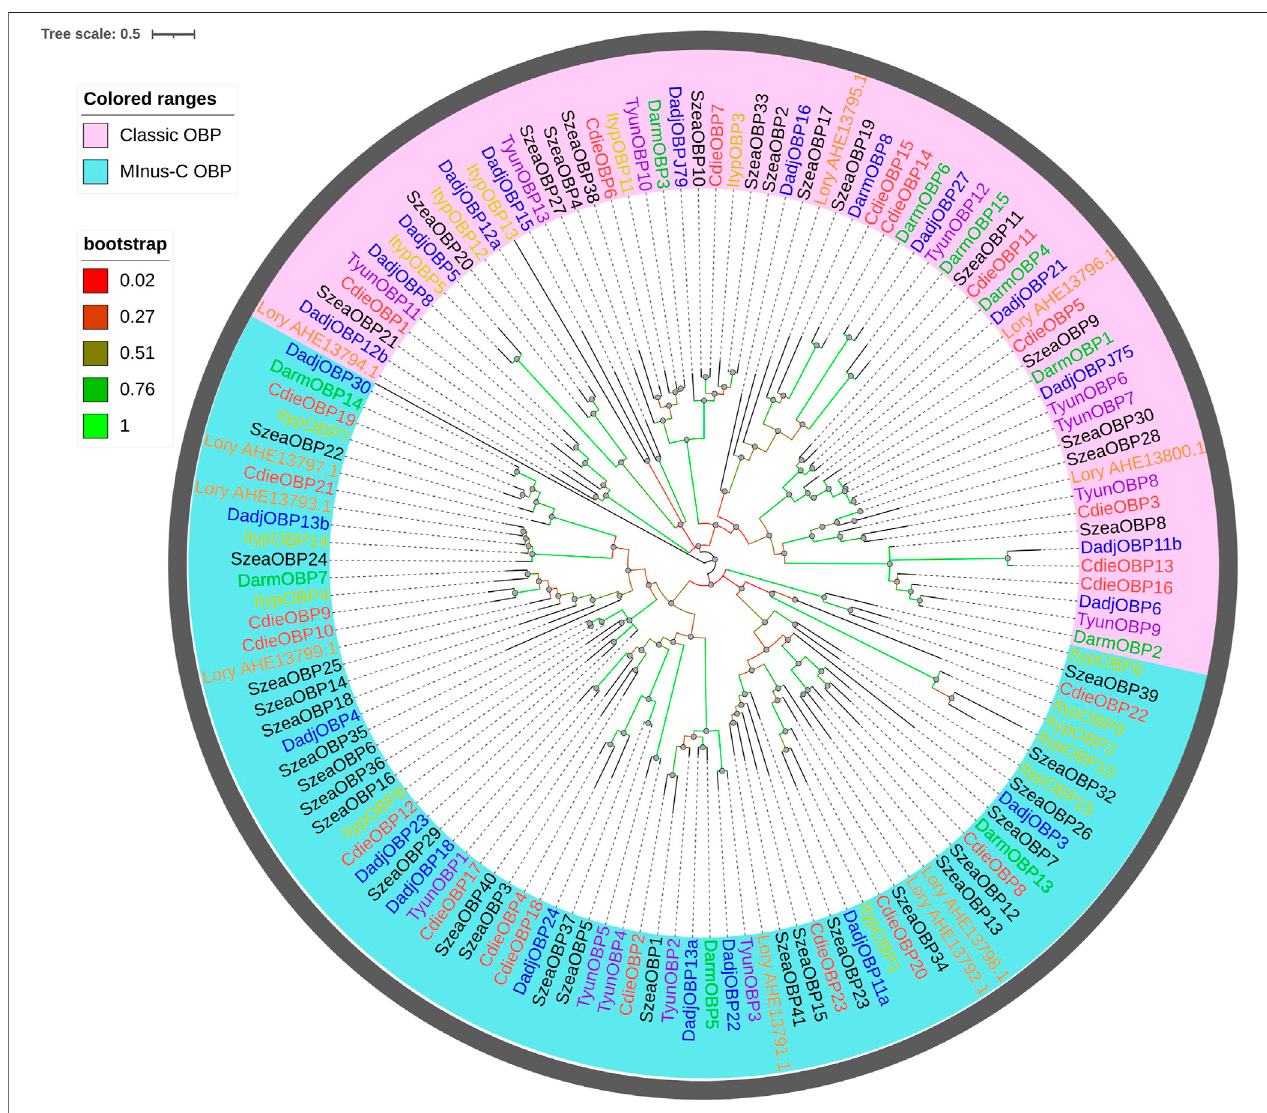
FIGURE 2 | Maximum likelihood tree of OBPs in C. dieckmanni (Cdie, red), D. adjunctus (Dadj, blue), D. armandi (Darm, green), Ips typographus (Ityp, yellow), Lissorhoptrus oryzophilus (Lory, orange), S. zeamais (Szea, black), and T. yunnanensis (Tyun, purple). The scale bar represents 0.5 amino acid substitutions per site.